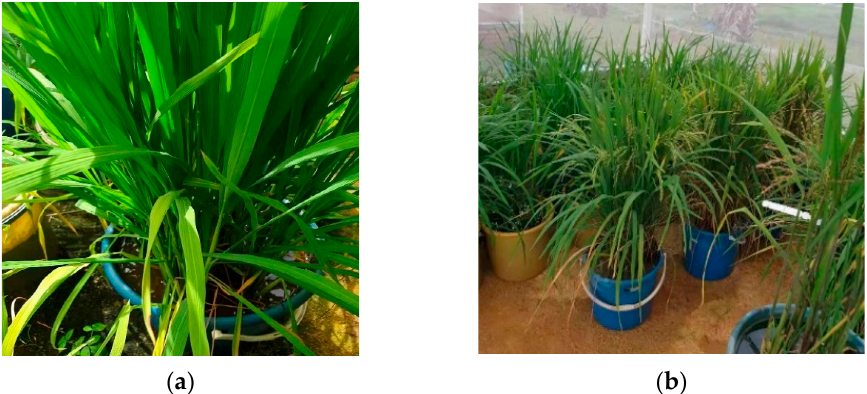
Figure 2. The original image of the rice leaves. ( a ) Stem elongation stage, ( b ) Flowering stage.